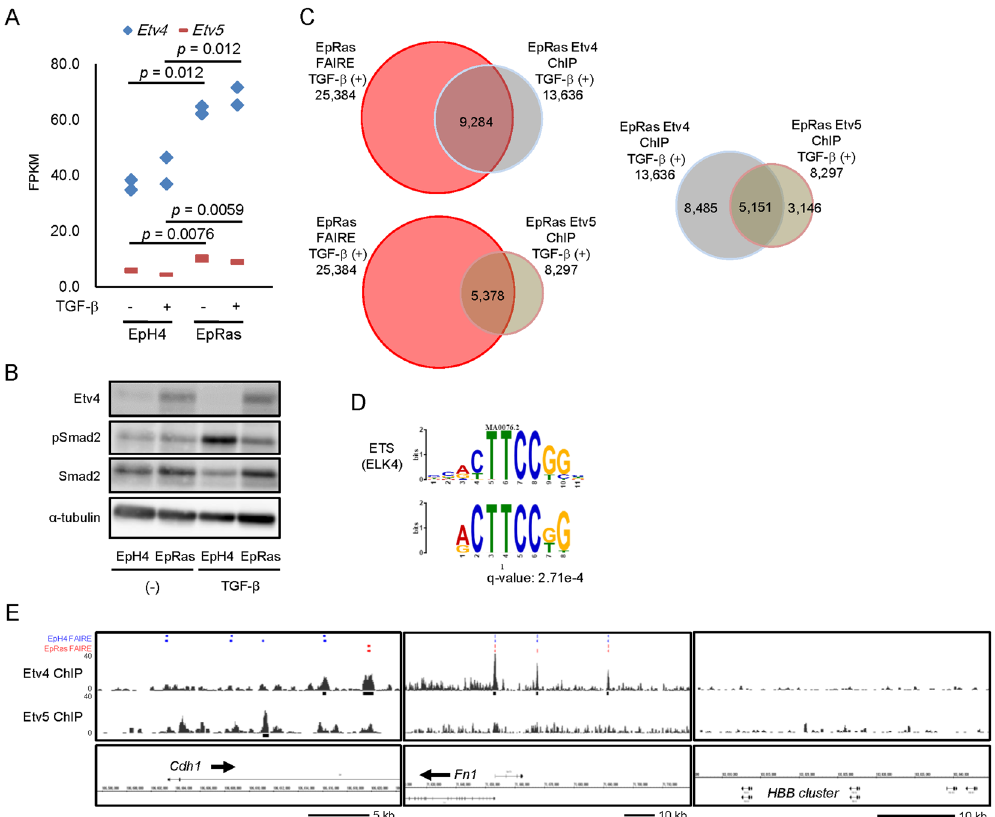
Figure 4. Global analysis of Etv4 and Etv5 binding regions in the genome. ( A ) Expression of Etv4 and Etv5 by RNA-seq of EpH4 and EpRas cells treated with 1 ng/ml TGF- β for 48 h. FPKM, fragments per kilobase of exons per million mapped fragments. The experiment was performed in two biological replicates. Data are a subset of the findings shown in Supplementary Fig. S2C. ( B ) Immunoblot analysis of endogenous Etv4 protein expression in EpH4 and EpRas cells. pSmad2, phosphorylated Smad2. ( C ) Relationship between the anti-Etv4 and anti-Etv5 ChIP-seq data and FAIRE-seq data obtained from TGF- β -treated EpRas cells. ( D ) De novo motif prediction identifies ETS family (ELK4) binding motif, and shown as in Fig. 3A. Anti-Etv4 ChIP-seq data were used for enriched motif calculation. q value (minimal false discovery rate required to include the motif) is shown. ( E ) Etv4 and Etv5 binding regions at the Cdh1 and Fn1 gene loci. HBB cluster region is shown as a control. Black bars represent the significant Etv4 and Etv5 binding regions. Significant FAIRE-positive regions in EpH4 and EpRas cells, without (first row) and with (second row) TGF- β stimulation, are shown as blue and red bars, respectively, as a reference (shown in Fig.